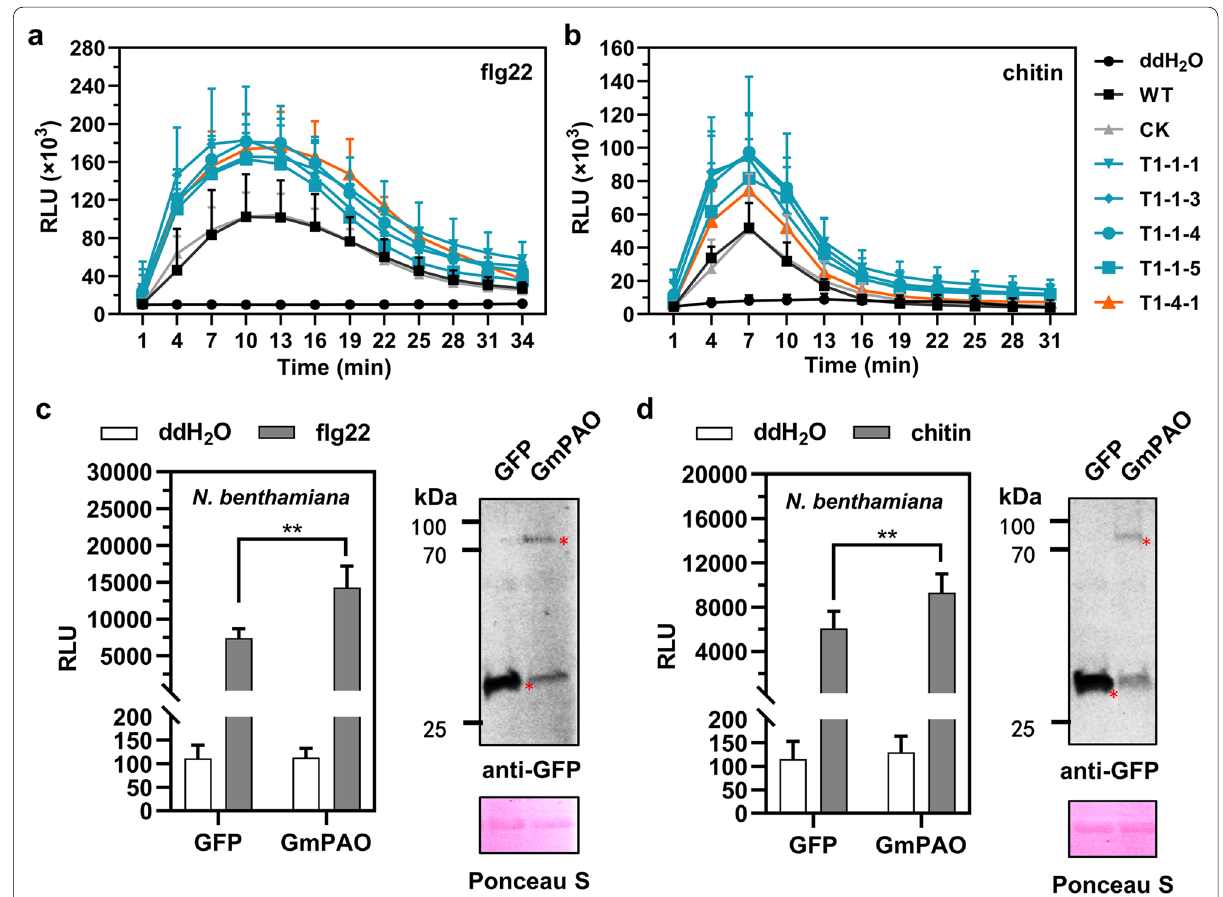
Fig. 2 GmPAO promotes PAMP (flg22 or chitin)-induced H 2 O 2 accumulation. a , b GmPAO promoted PAMP (flg22 or chitin)-induced H 2 O 2 accumulation in transgenic soybean lines. The leaves (2-week-old) were subjected to flg22- ( a ) or chitin-induced ( b ) ROS examination,